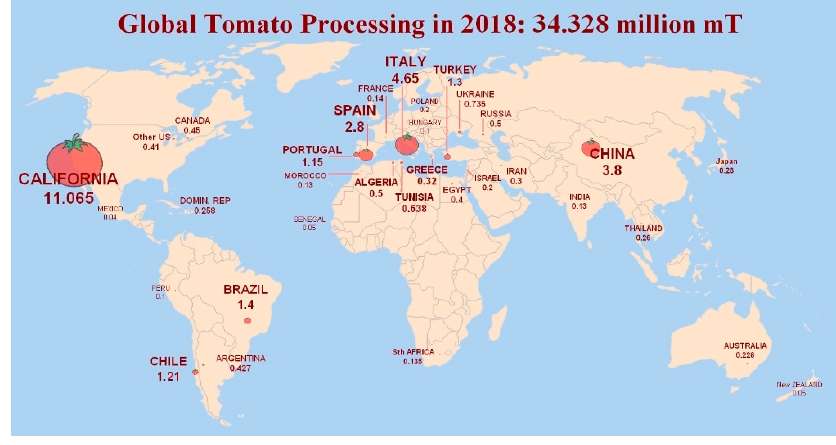
Figure 1. Global tomato processing in 2018 [9].